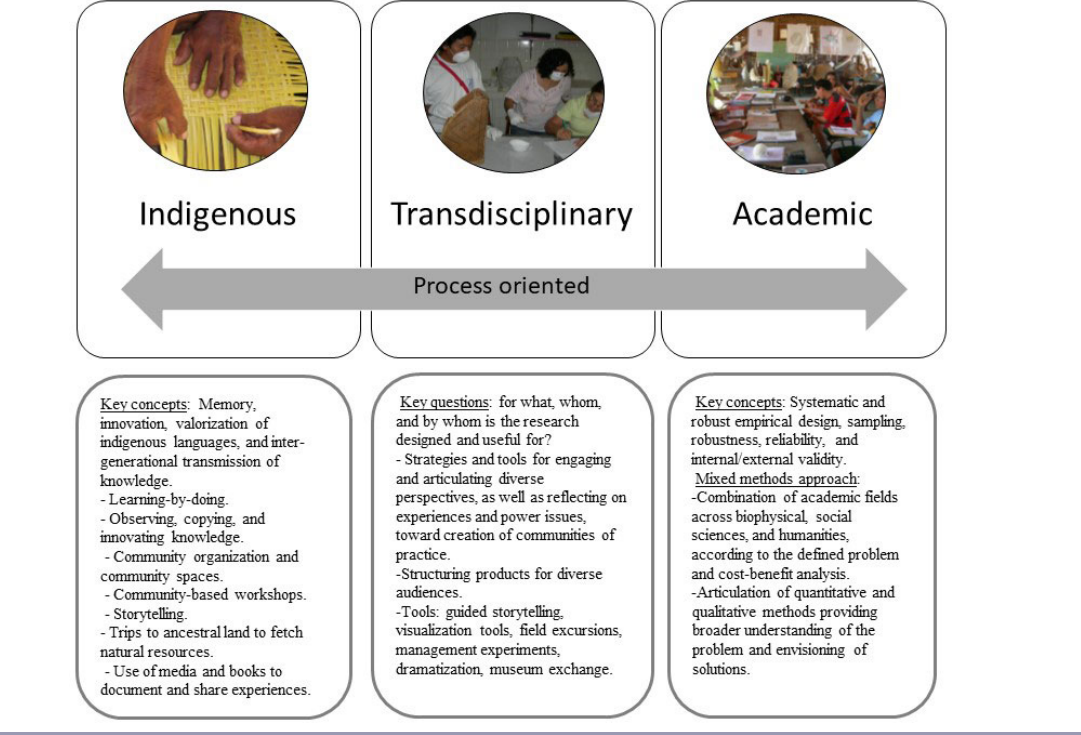
Fig. 2 . Methods and approaches used for creating, assessing, and communicating artistic knowledge by indigenous peoples and academic researchers participating in the Kaiabi Araa participatory action-research